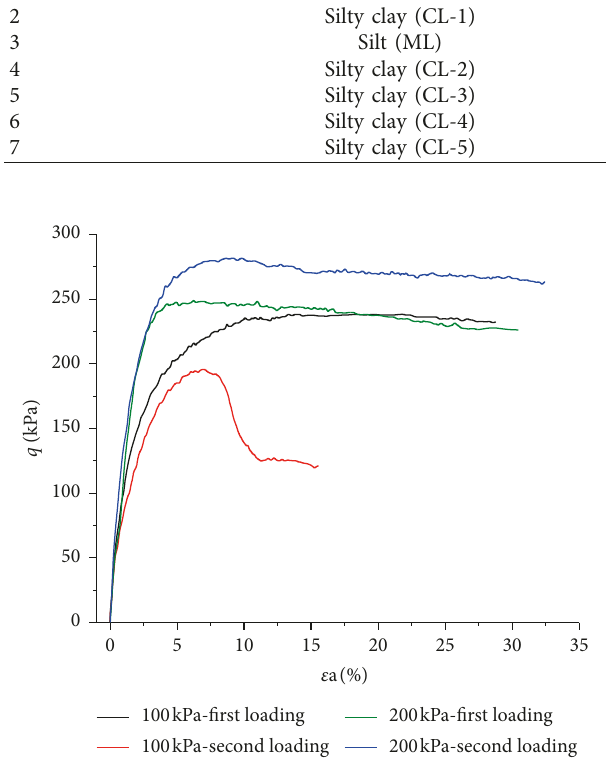
Figure 5: Stress-strain curves of silty clay (CL-2) under repeated loading.